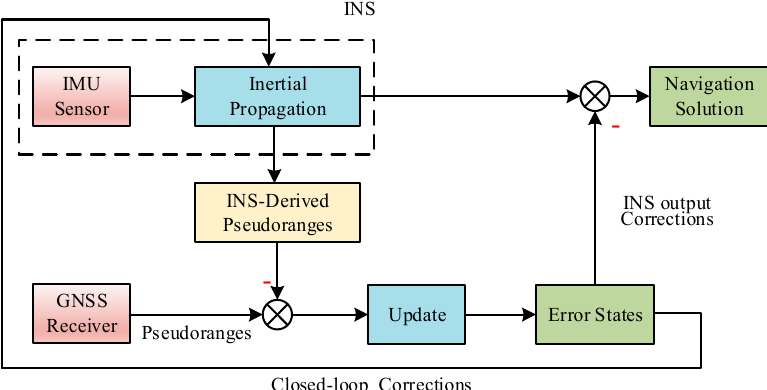
Figure 1. Closed-loop error-state Global Navigation Satellite Systems (GNSS) / Inertial Navigation System (INS) tight integration architecture.